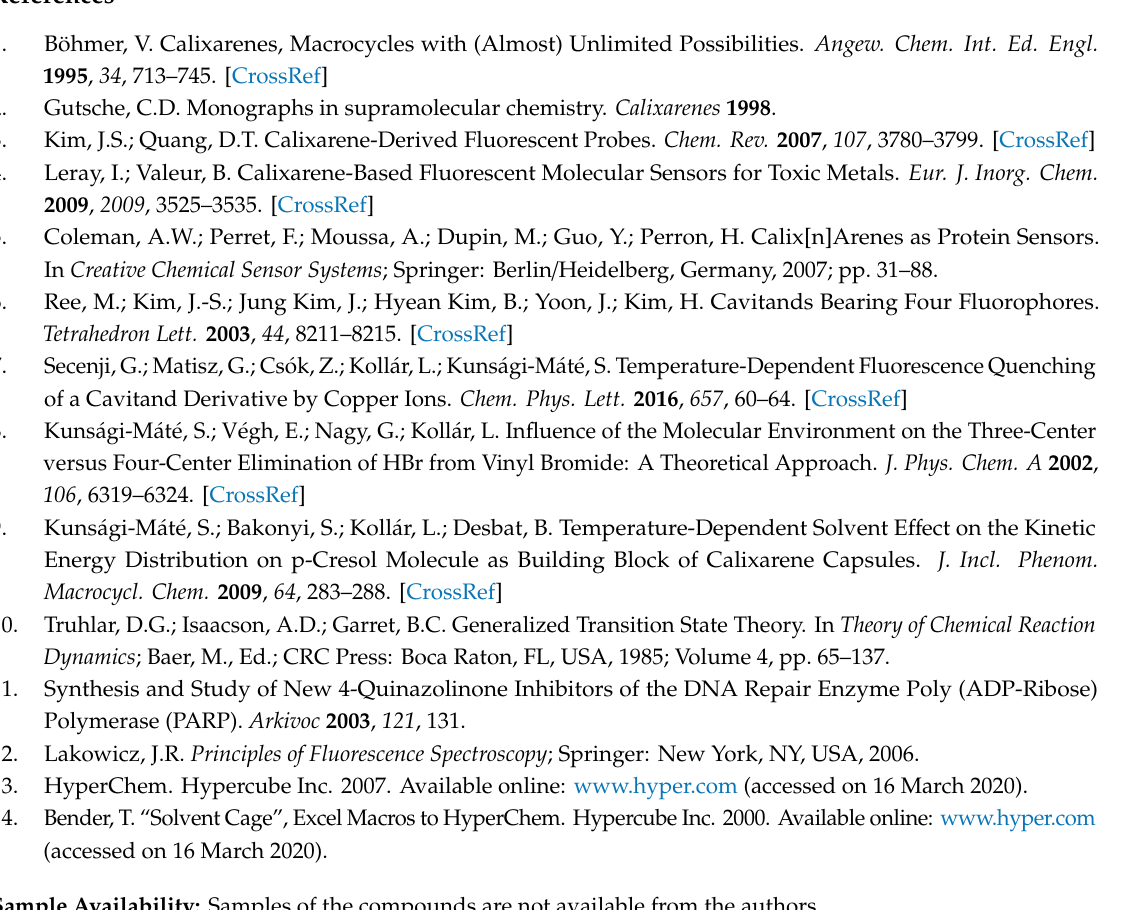
Supplementary Materials: The following are available online, Table S1: Results derived by the Benesi-Hildebrand method, Table S2: Results derived by the Hyperquad